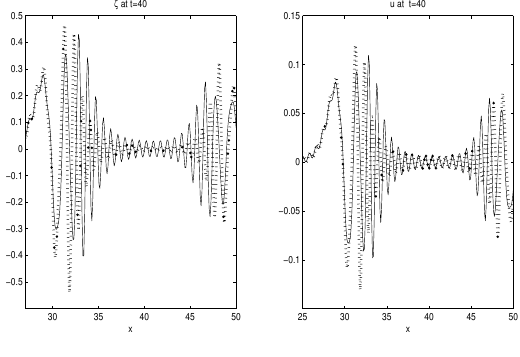
Figure 7. In points: numerical solution of system (1.1) without terms of order O ( (cid:15) 2 ). In solid line: numerical solution of full system (1.1).